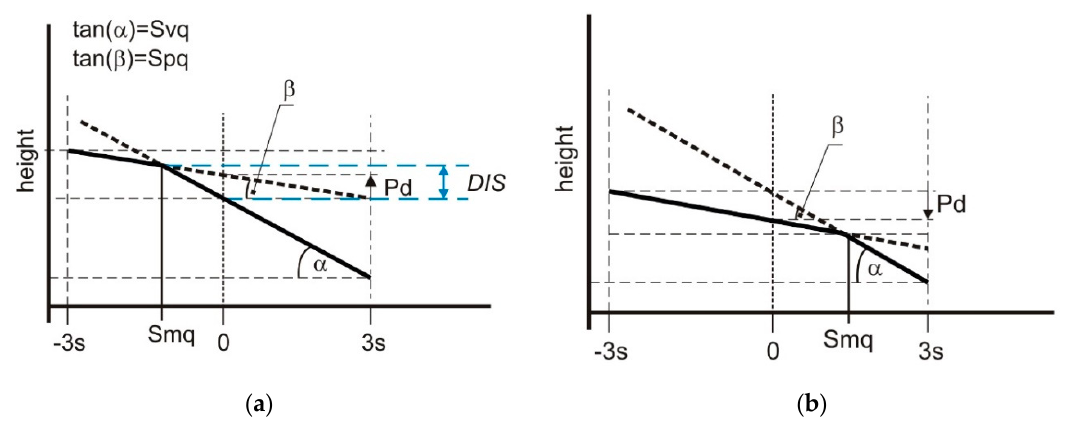
Figure 2. Probability plots of material ratio curves for different two-process surfaces; the Smq parameter is smaller than 50% ( a ) and the Smq parameter is higher than 50% ( b ) with plateau depth Pd and the vertical distance between two modes DIS.